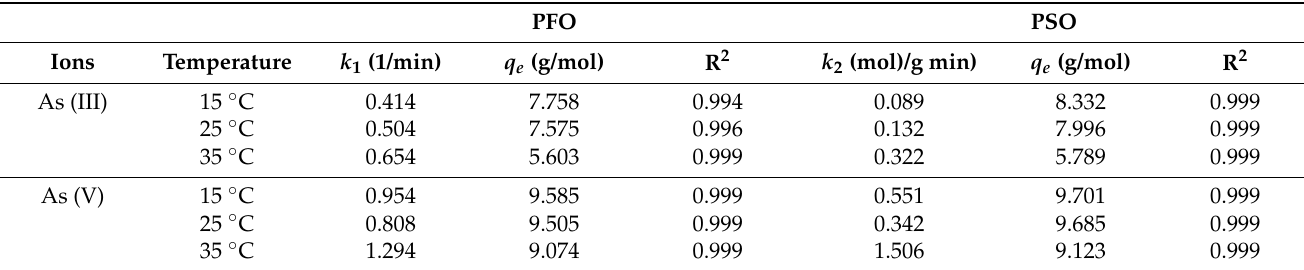
Table 2. Sorption kinetic parameters of trivalent and pentavalent As ions on precipitated FHO under various temperatures (15–35 ◦